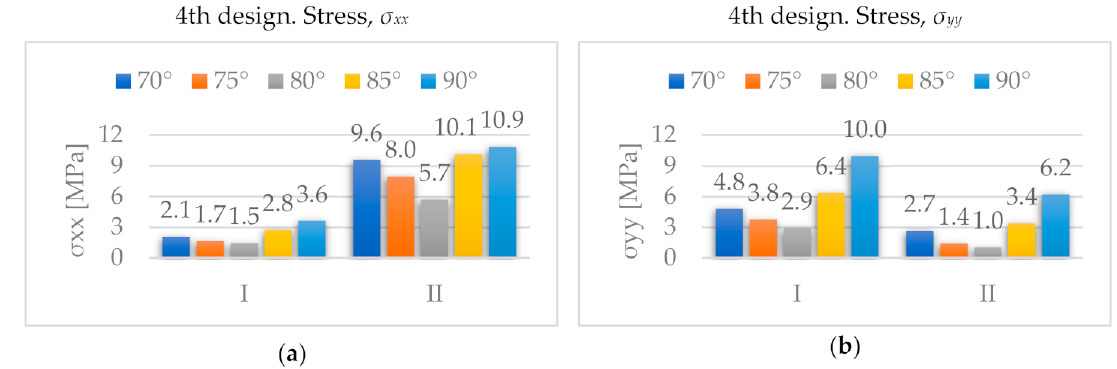
Figure 17. Evolution of maximum stresses [MPa] with α , for the 4th design: ( a ) σ xx ; ( b ) σ yy .